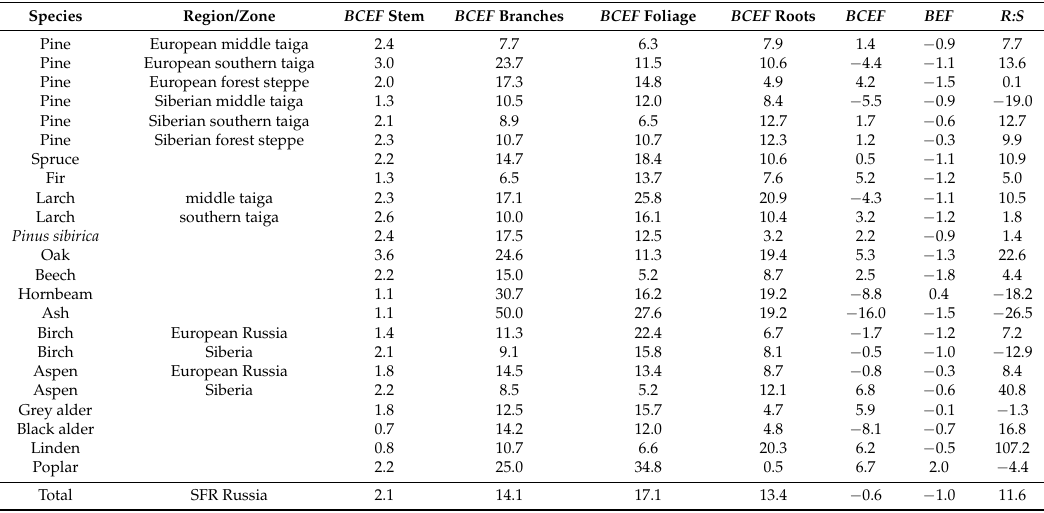
Table 1. Relative error of the models